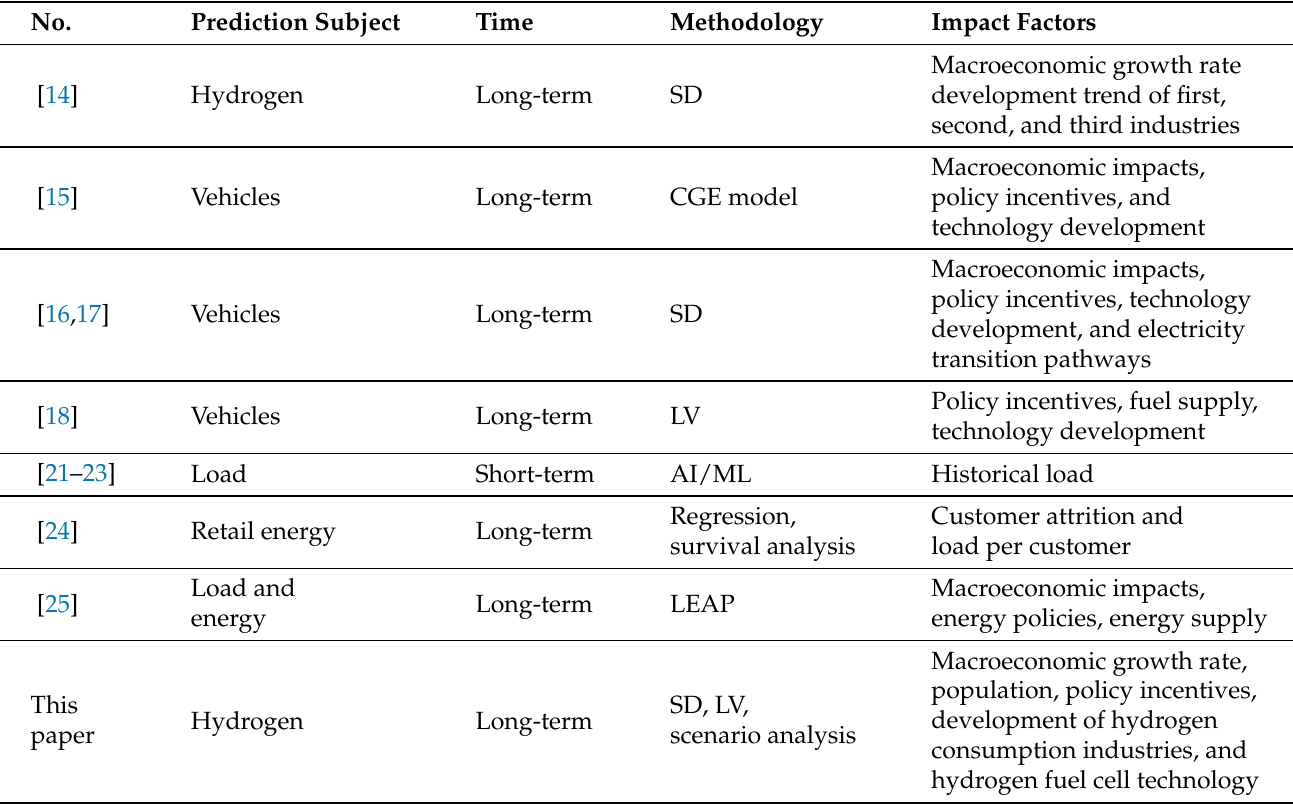
Table 2. Major differences between representative references and this